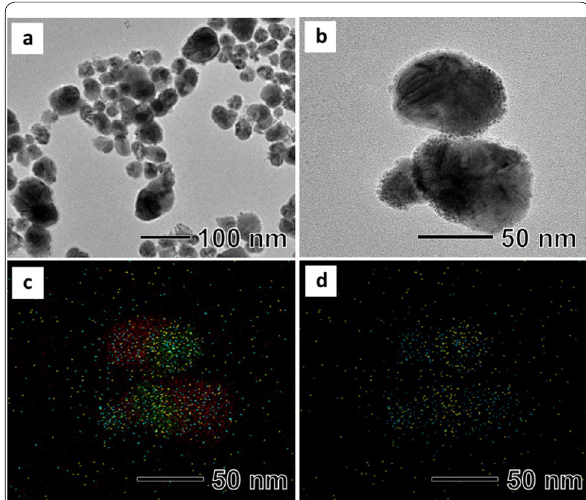
Fig. 1 a , b TEM images of synthesized Ag–Cu‑Pt–Pd nanoparticle,